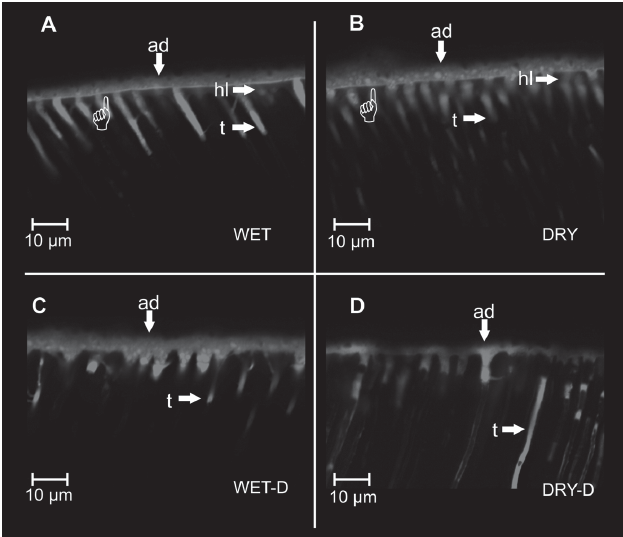
Fig. 1 CLSM images of the resin-dentin bonding interfaces (ad = adhesive; hl = hybrid layer; t = resin tag). The specimens not exposed to NaOCl (A, B) showed formation of a collagen-resin hybrid layer; a distinct layer of adhesive concentration above the hybrid layer (pointers) was also observed. The WET group showed deeper penetration of the bonding agent into the dentinal tubules than the DRY group. No hybrid layer formation or bonding agent concentration was observed for the deproteinized groups (C, D). The DRY-D group showed a thicker layer of bonding agent and deeper penetration of the bonding solution into the dentinal tubules compared to the WET-D